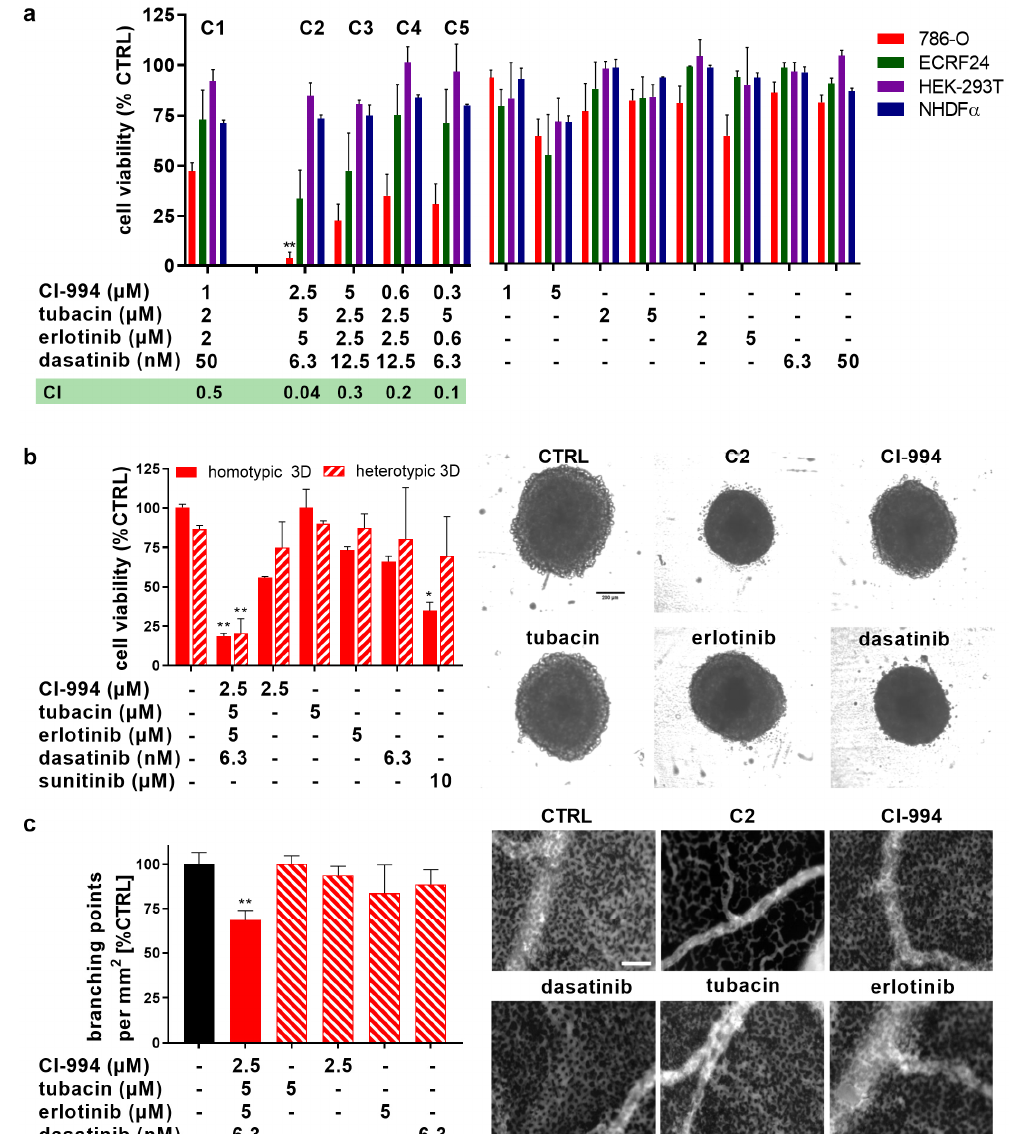
Figure 2. Dose optimization and validation of the OCD efficacy in 3D cell cultures with sunitinib-resistant cells and anti-angiogenic ODC potential in the chorioallantoic membrane model (CAM). ( a ) The efficacy of the five most promising drug combinations ( C1–C5 ) derived from the dose optimization with C1 , identifying C2 as the most effective drug combination. Corresponding single drug treatments are presented for the 786-O cell line, non-malignant renal HEK-293T control cells, as well as in nonmalignant NHDF α fibroblasts and activated ECRF24 endothelial cells. Green box: the “combination index” (CI) values for each drug combination with CI < 1 indicating synergy (highlighted in green), 0 and CI > 1 indicating antagonism. * p < 0.05 and ** p < 0.01 represent significant increased activity of C1 compared to C2–C5 and corresponding single drug treatments as determined by a one-way ANOVA with post hoc Sidak’s multiple comparison test from N = 2–4 independent experiments. ( b ) Efficacy and representative images of the dose-optimized drug combination C2 in 3D homotypic (786-O) spheroids or in 3D coculture heterotypic spheroids containing human fibroblasts, 786-O (1:1) and 10% ECRF24 endothelial cells. Sunitinib at 10 μ M was used as a positive control. Scale bar represents 200 μ m for all images. ( c ) In vivo inhibition developmental angiogenesis evaluated in the chorioallantoic membrane (CAM) model of the chicken